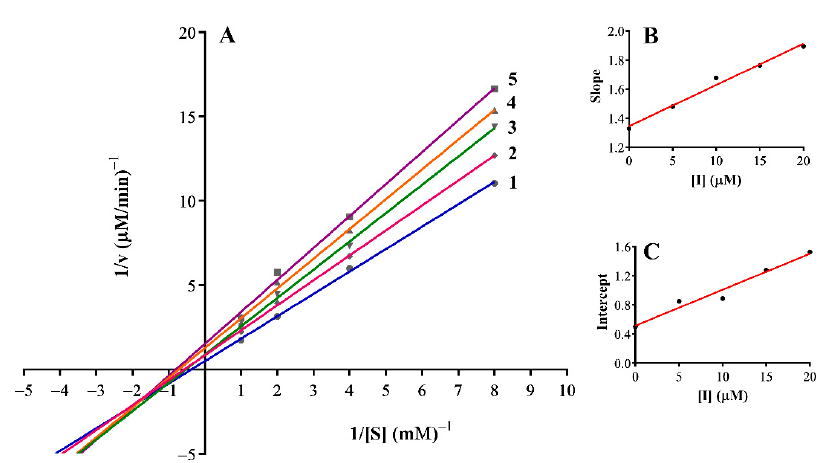
Figure 3. ( A ) Lineweaver − Burk plots for the inhibition of 17 on the mushroom tyrosinase for the catalysis of L-tyrosine at 28 ◦ C, pH 6.8. Concentrations of 17 for curves 1–5 were 0.0, 5.0, 10.0, 15.0 and 20.0 µ M, respectively. The insets ( B , C ) represent the secondary plot of the slopes and intercepts versus concentrations of 17 to determine the inhibition